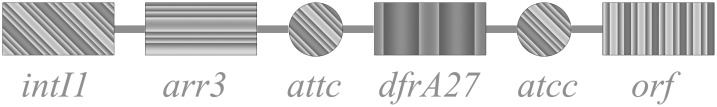
Schematic diagram of resistance gene cassettes located in the class 1 integron from Stenotrophomonas maltophilia isolates.